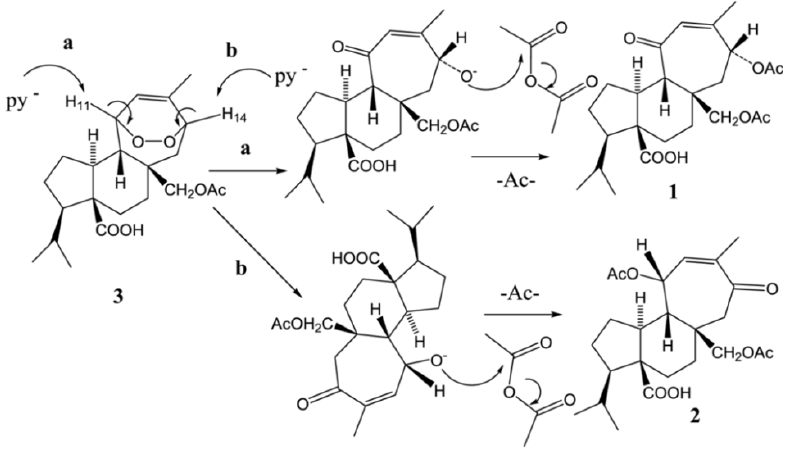
O in pyridine at 25 2